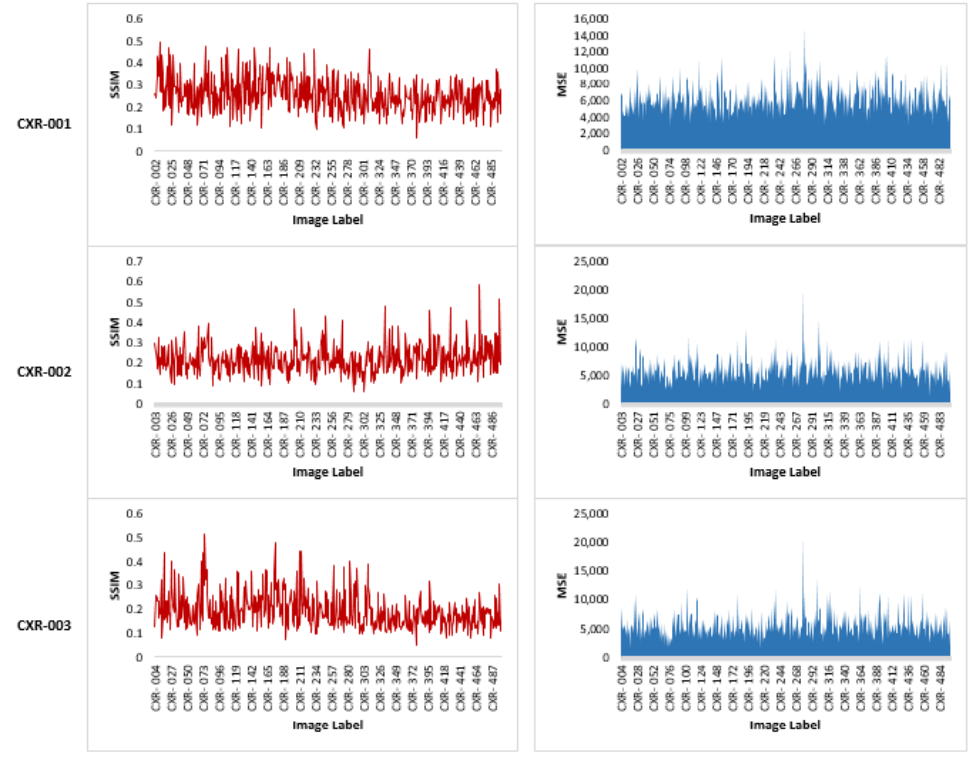
Figure 10. Samples of MSE and SSIM values between three selected images and the other images.